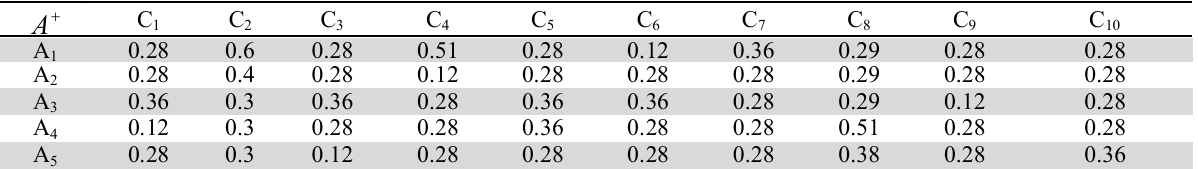
Fuzzy positive ideal solution